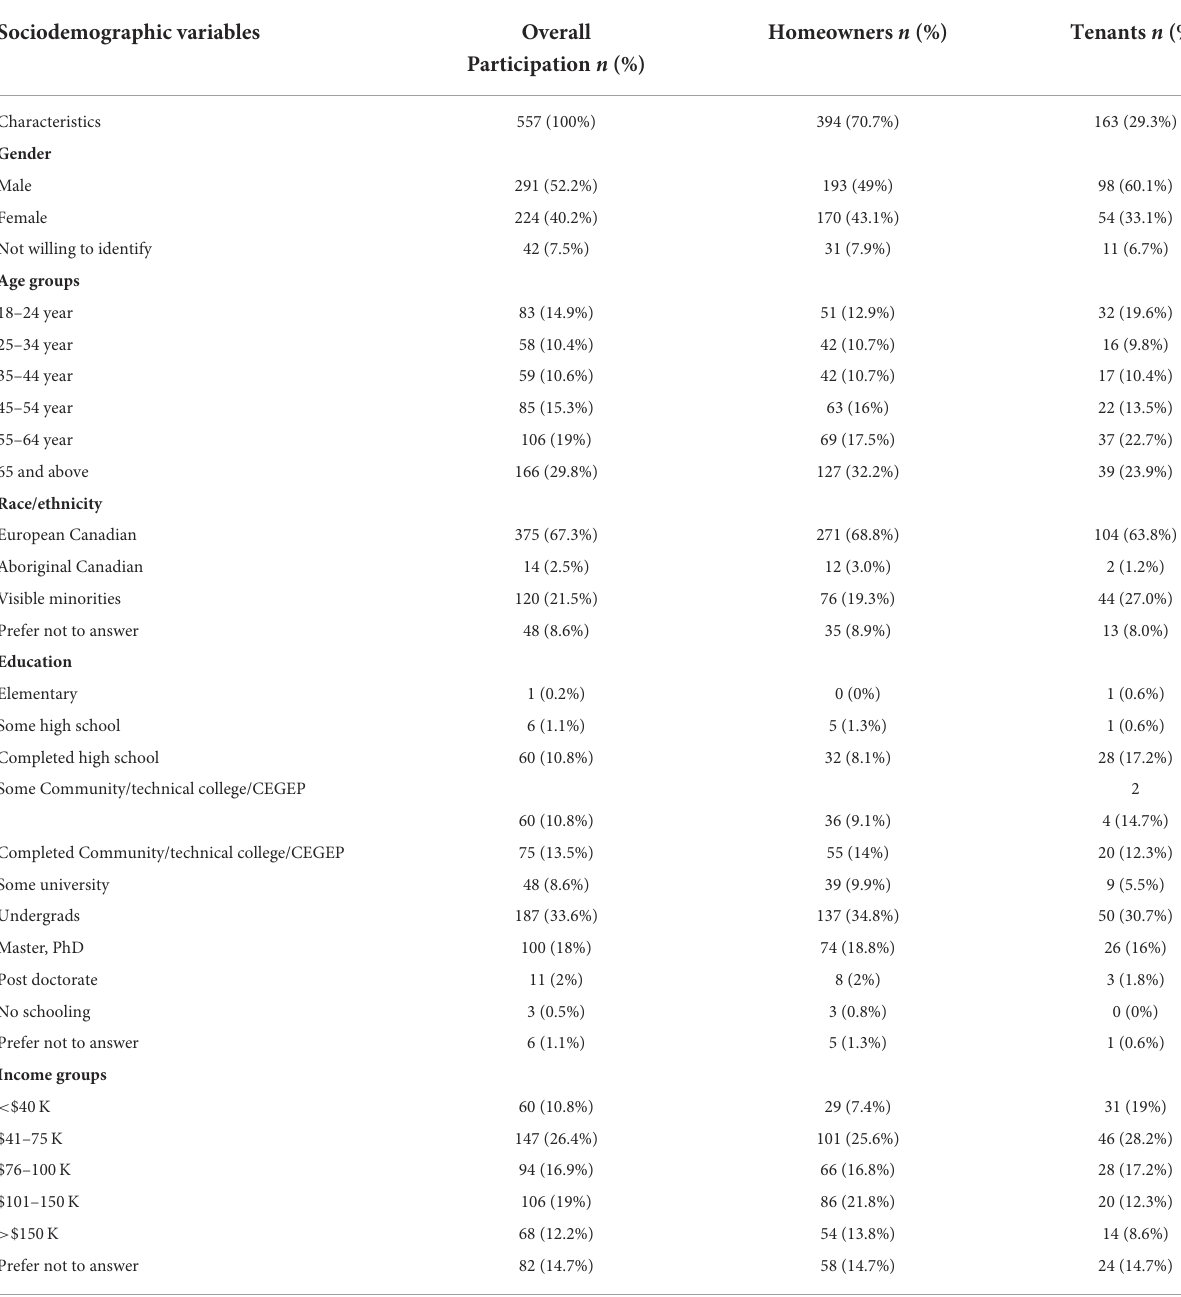
TABLE 1 Demographics of survey (quantitative)